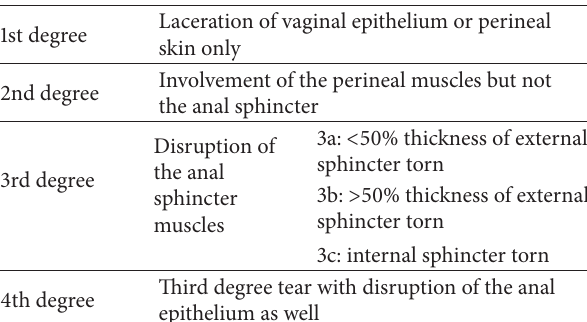
Table 1: Sultan’s classification of perineal trauma. Table 2: Types of vaginal